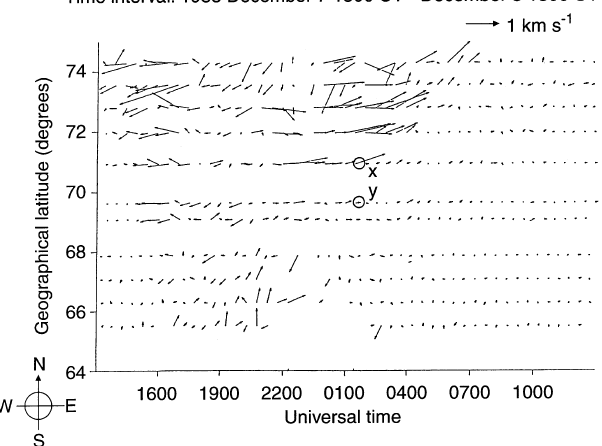
Fig. 6 EISCAT measurements of plasma velocity on 7–8 December 1988. The arc was observed between the locations represented by ‘x’ and ‘y’